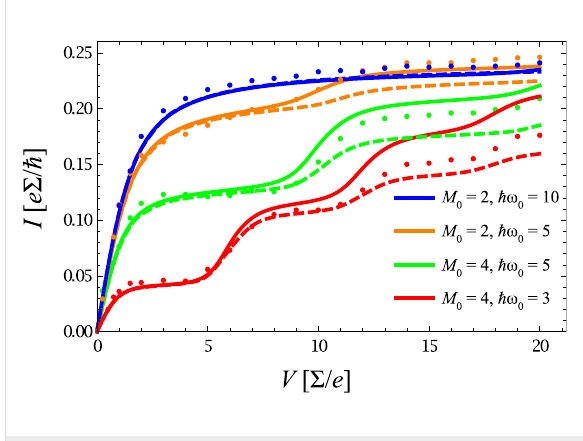
Figure 6: I – V characteristics according to approximate models based on equilibrated phonons (solid) and nonequilibrated phonons (dashed) together with exact DQMC data (dots) for k B T / ∑ = 0.2 and without coupling to a secondary bath ( γ = 0). All quantities are scaled with respect to the dot–lead coupling ∑ .